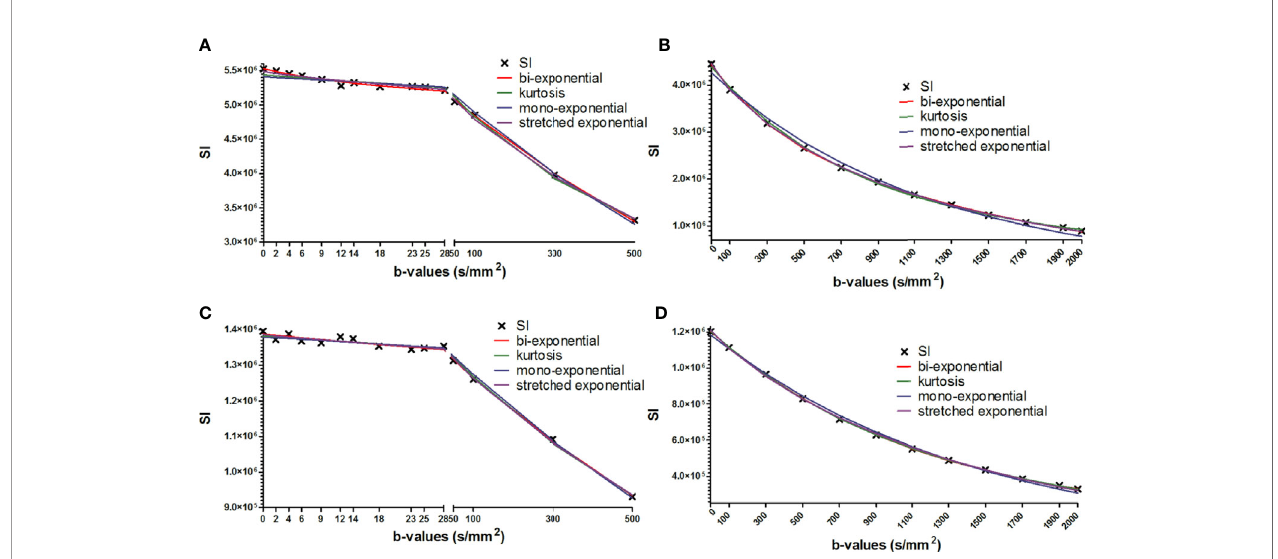
FIGURE 3 | Mean signal intensity as a function of b-values (x-axis) fi tted using all four models. The data is shown for the same representative tumor as shown in Figures 1 and 2. (A) ; week 1, low b-value DWI data. (B) ; week 1, high b-value DWI data. (C) ; week 4, low b-value DWI data. (D) ; week 4 high b-value DWI data. Bi-exponential, kurtosis and stretched exponential models provide better fi t to the DWI decay curve than the mono-exponential model especially at high b-value DWI data.